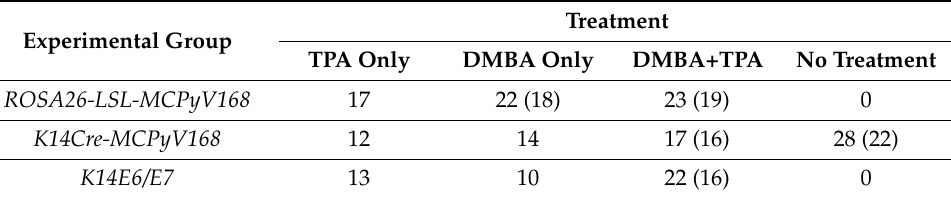
Table 1. Overview of treatment groups and number of mice per group at study onset and endpoint. Starting number of mice per each treatment group and genotype are shown. The number of mice remaining at 20 weeks post-DMBA treatment is shown in parentheses. Any change in the number of mice per group is accounted for in statistical tests at each time